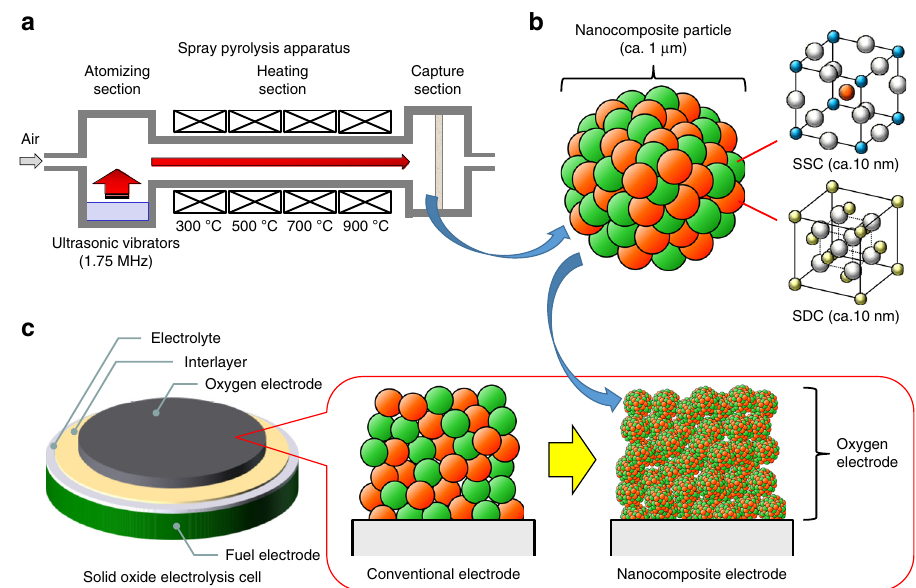
Fig. 1 Schematics of nanocomposite electrodes. a Spray pyrolysis apparatus consisting of atomization, heating, and capture sections. b Conceptual images of an SSC-SDC nanocomposite particle and c a bimodal-structured SSC-SDC nanocomposite electrode fabricated using the SSC-SDC nanocomposite